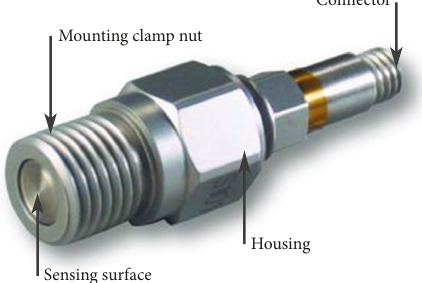
Figure 12: Ground-surface